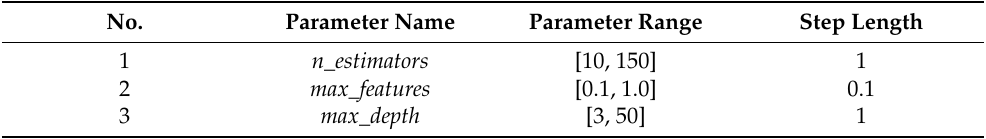
Table 5. GSCV-RF Model Parameter Optimization Settings.